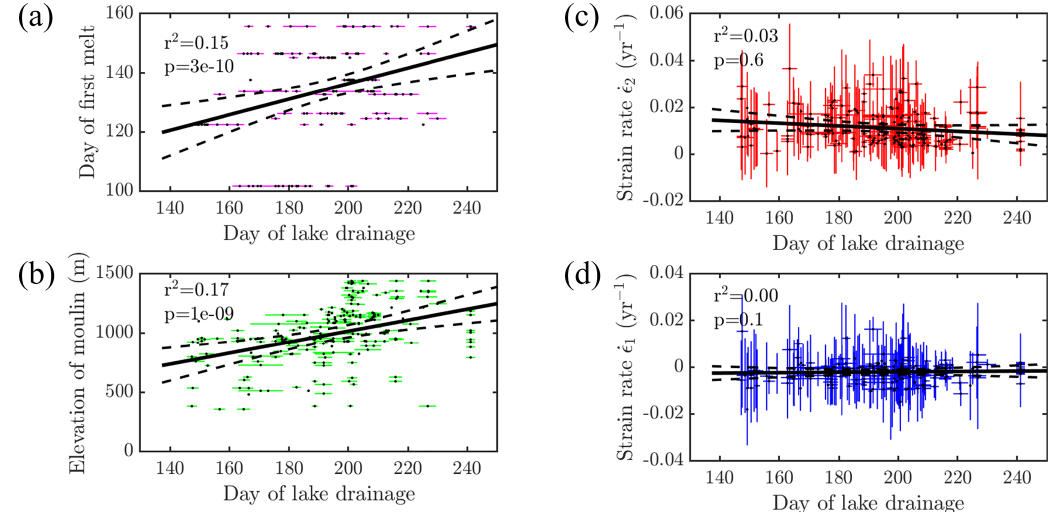
Figure 9. Results of four univariate regressions for lake drainage date for N = 212 fast-lake-drainage events identified with high confidence over the 19 melt seasons from 2006–2010 and 2013–2018. Thick black lines show the univariate least-squares fits to each time series, dashed lines show the 99% confidence bands on each fit, and the Pearson correlation coefficients ( r 2 ) and p values from a separate multivariate regression are indicated. (a) Date of melt onset versus the day of fast lake drainage for these 11 years (dots), with uncertainties on the date of lake drainage (magenta). (b) Scatter plot of moulin elevation versus the day of drainage of the fast-draining lake each moulin is connected to (dots), with uncertainties on the date of lake drainage (green). (c) Scatter plot of background extensional principal strain rate ˙ (cid:15) 2 versus the day of drainage of the fast-draining lake each moulin is connected to (dots), with uncertainties on the strain rate and on the date of lake drainage (red). (d) Scatter plot of background compressional principal strain rate ˙ (cid:15) 1 versus the day of drainage of the fast-draining lake each moulin is connected to (dots), with uncertainties on the strain rate and on the date of lake drainage